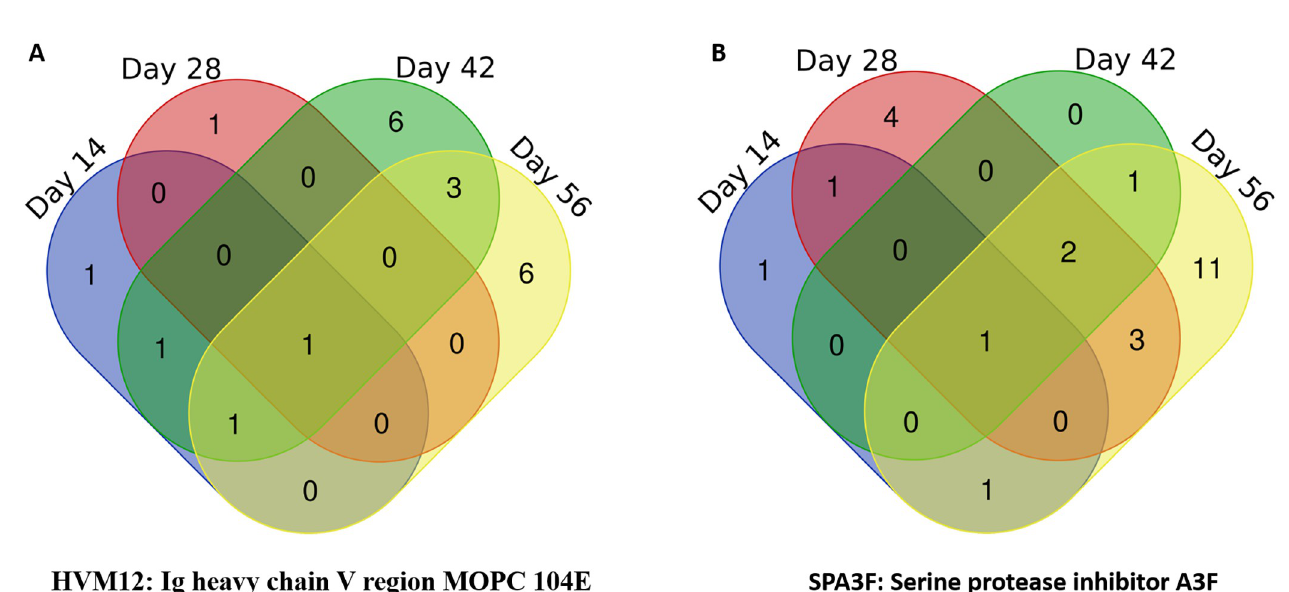
Fig 3. Up-regulated (A) and down-regulated (B) mouse serum proteins 14-, 28-, 42-, and 56-days post-infection with S . mekongi .